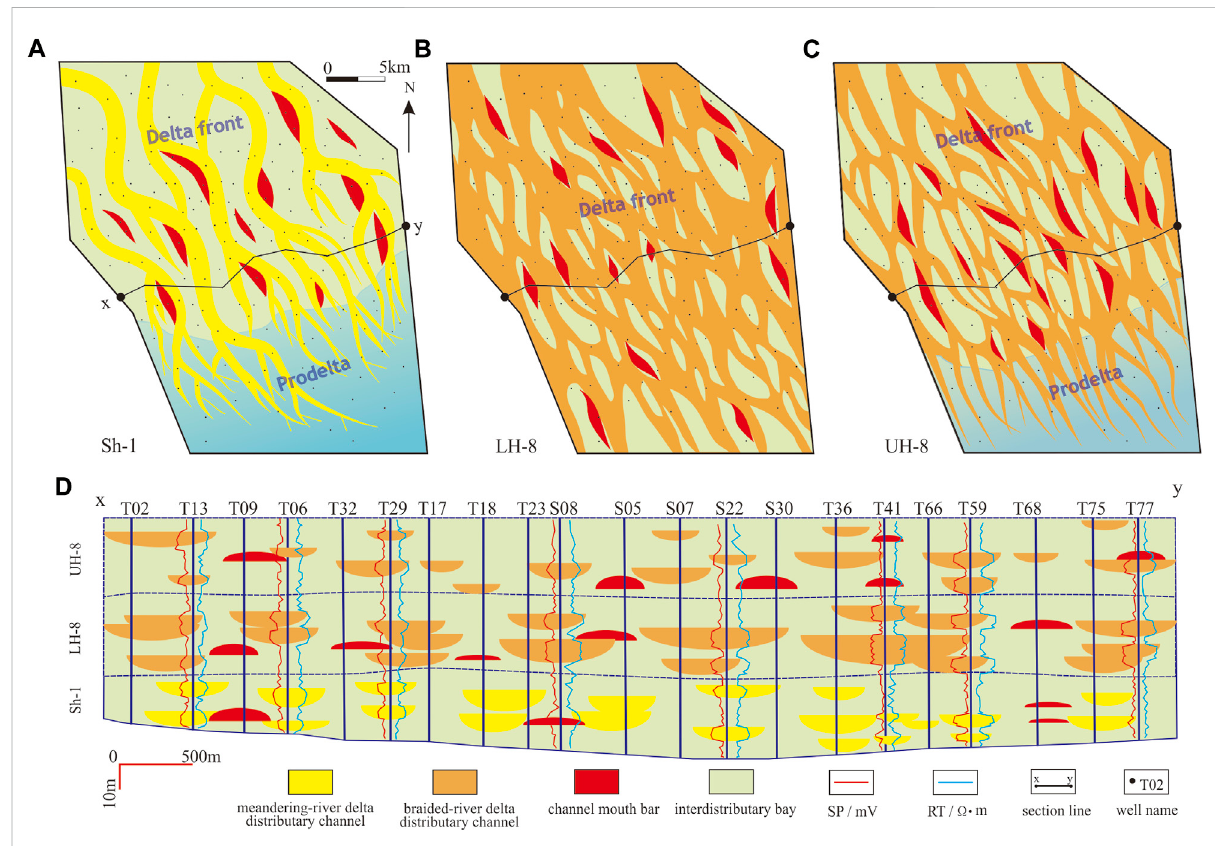
FIGURE 7 2D and vertical distribution characteristics of the delta in the Sh-1 to He-8 members. (A – C) represent the 2D distribution of sand bodies in the Sh-1 member, LH-8 member, and UH-8 member, respectively. (D) The pro fi le of sedimentary microfacies passing through the line x-y.